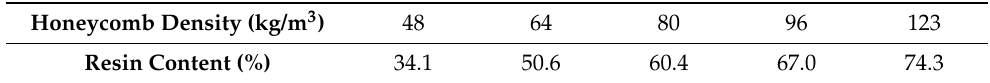
Table 1. The resin content for different density honeycomb